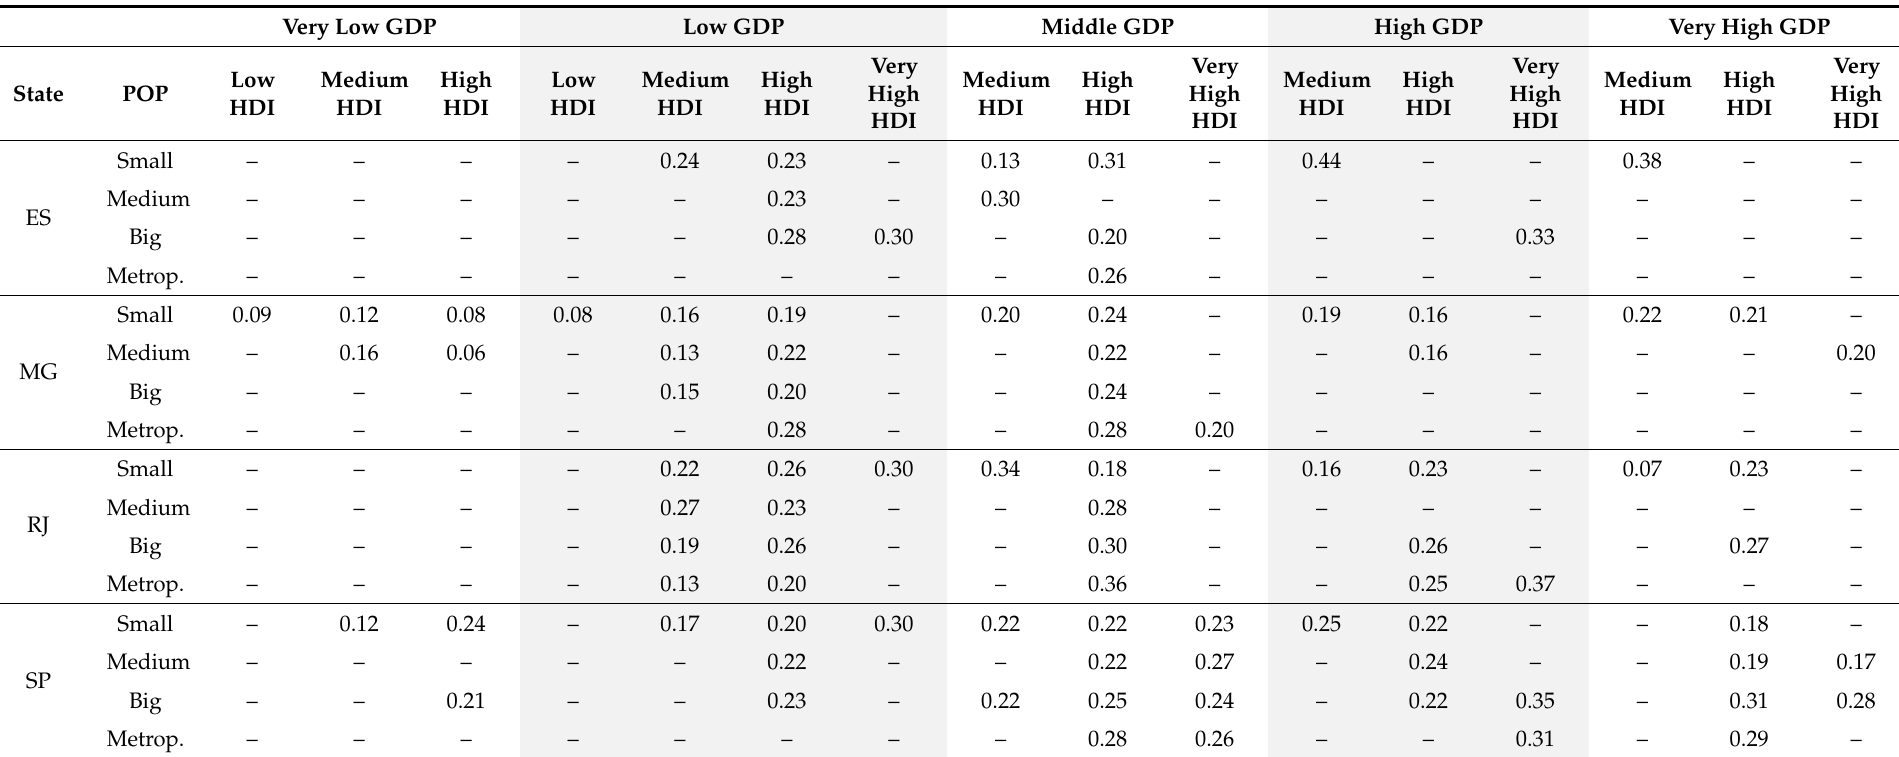
Table 2. Lethality rate over the 62 weeks in the 4 states of the Southeast region, according to population size (POP); gross domestic product (GDP); and Municipal Human Development Index (HDI-M), also over the course of 62 weeks of the pandemic. Very Low GDP Low